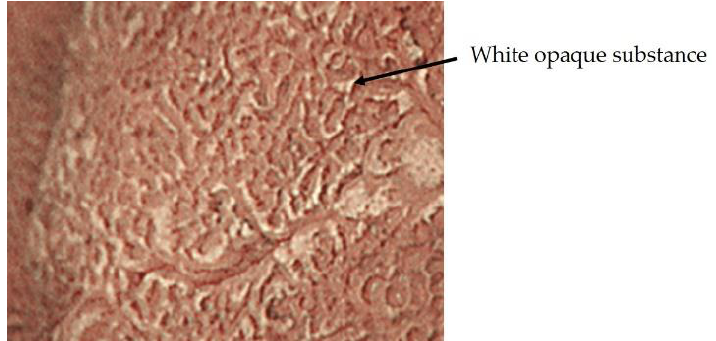
Figure 4. White opaque substance.